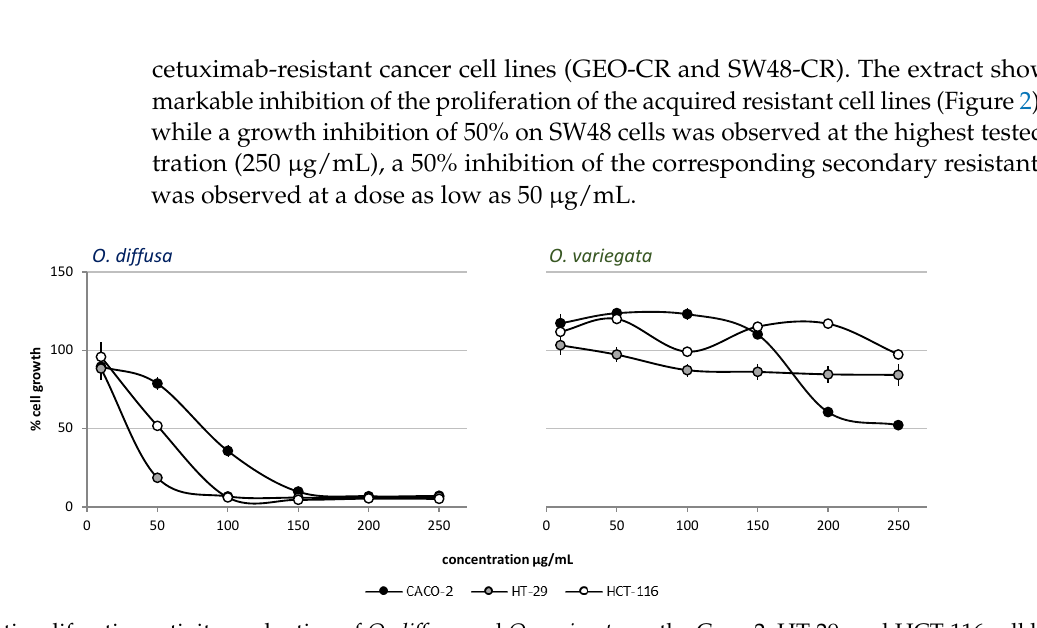
Figure 1. Antiproliferative activity evaluation of O. diffusa and O. variegata on the Caco-2, HT-29, and HCT-116 cell lines. Cell growth is expressed as percentage from control, and is plotted on the vertical axis, while doses of plant extracts are reported on the horizontal axis.